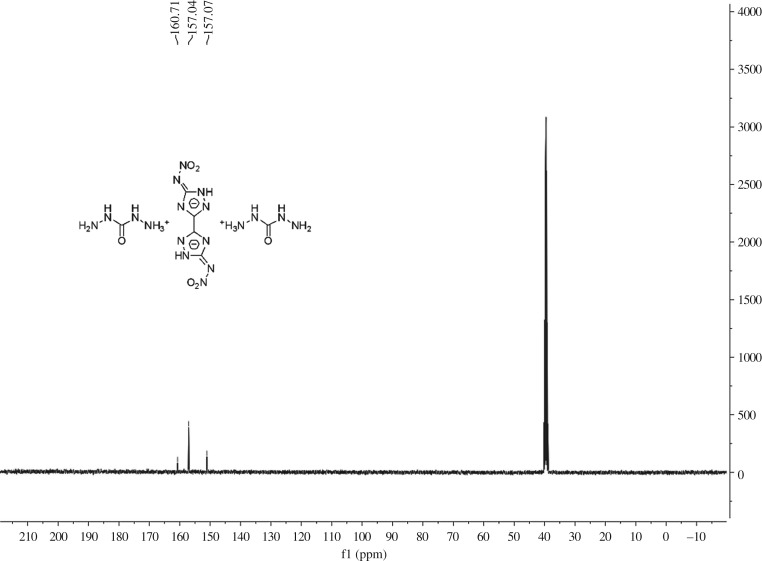
13C NMR spectrum of DCBNT.